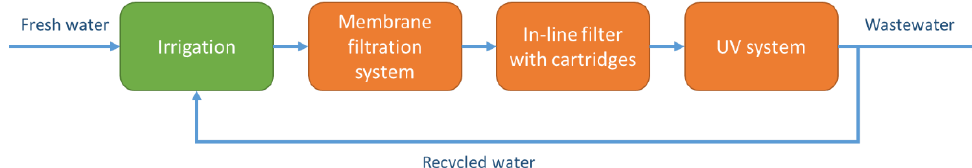
Figure 4. Scheme of the solution applied. In orange, the new system installed; in green, the irrigation process; blue arrows, water flows.